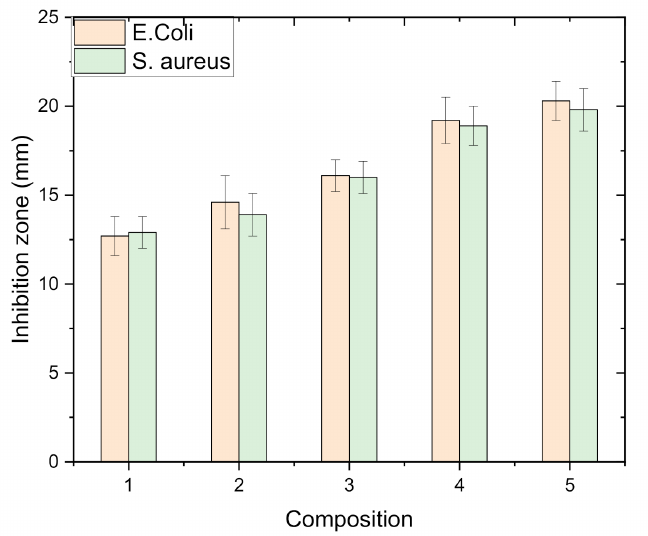
Figure 13. Antibacterial activity of HAP modified with co-doped Ag/V and incorporated into poly-